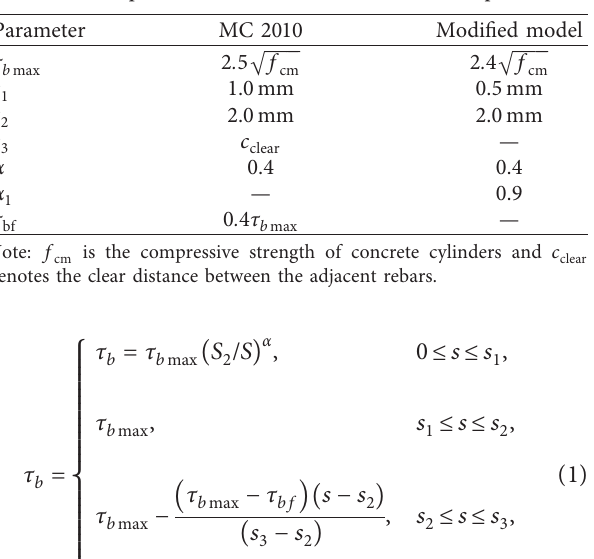
Figure 4: Comparison of bond stress-slip models. Table 1: The parameter values of the bond stress-slip